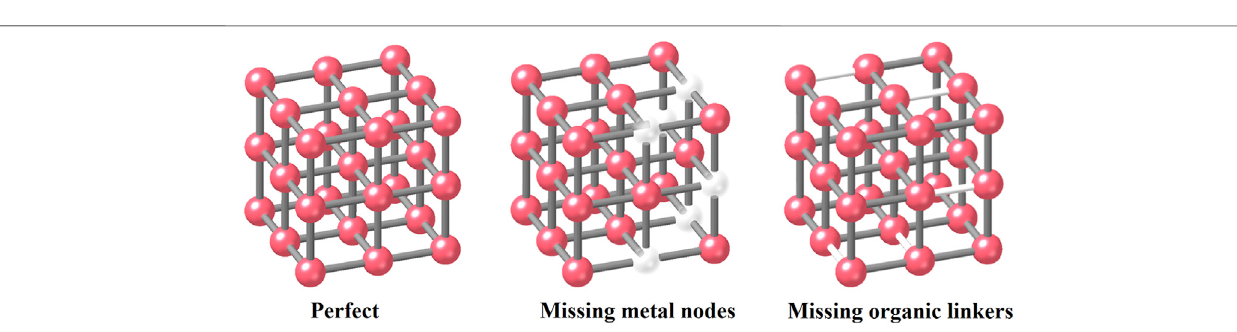
FIGURE 2 | Defect structure classi fi cation 2 with missing metal nodes or organic linkers.